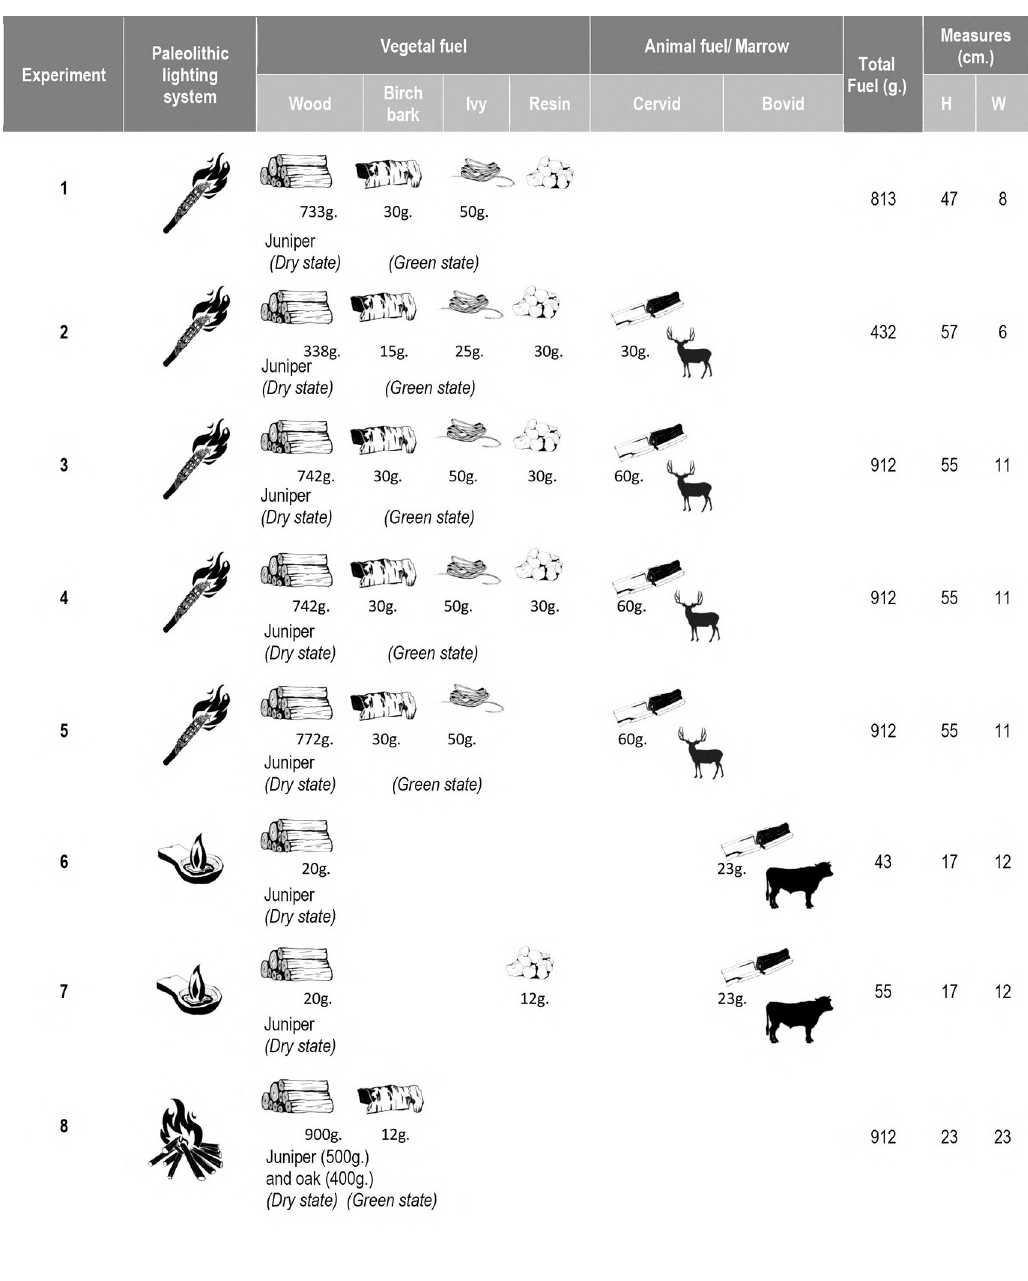
Fig 4. Fuel composition and measurements of the replicated torches, lamps, and